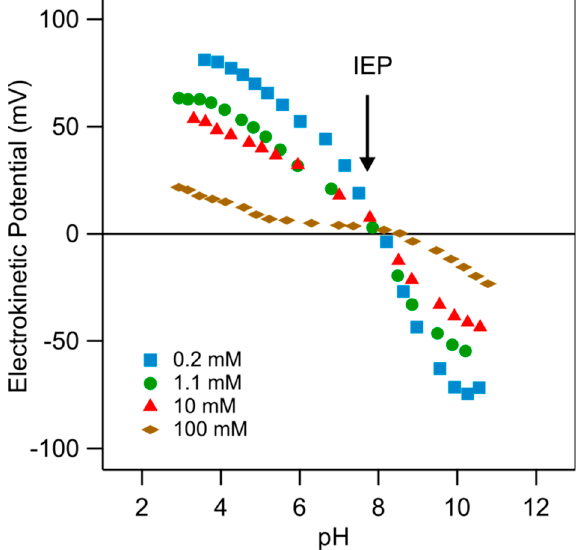
Figure 4. Dependence of the electrokinetic potential of the ex situ PDADMAC-functionalized surfaces on pH for different ionic strengths. The substrate was functionalized during 1 h in a PDADMAC solution of 5.0 mg/L with pH 4.0 and an ionic strength of 10 mM, resulting in an adsorbed amount of PDADMAC of 0.14 mg/m 2 . The isoelectric point (IEP) is located at pH 7.8.